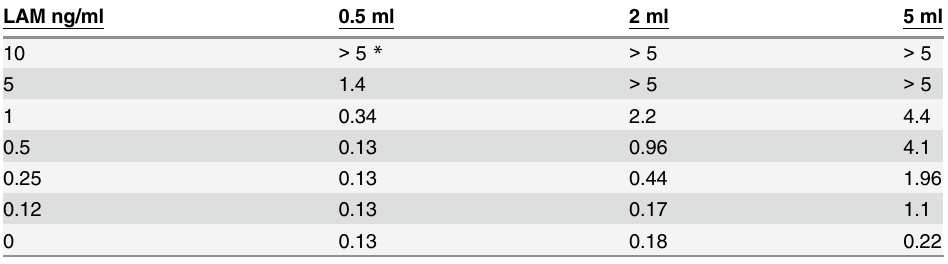
Table 2. Effect of urine volume on detection limit of the Uri-TB-direct assay. LAM ng/ml 0.5 ml